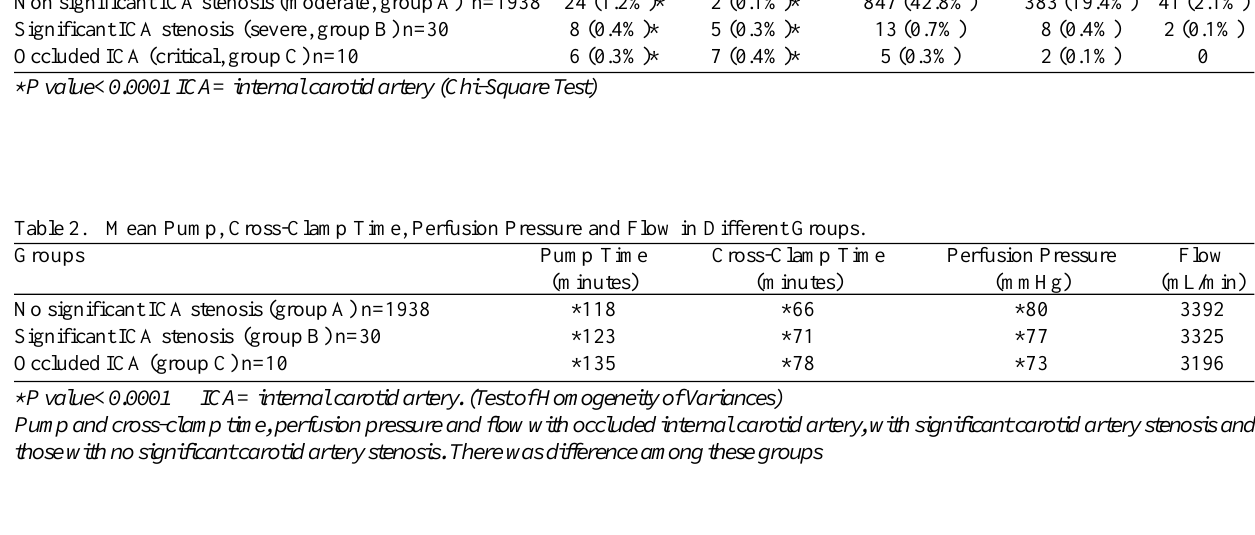
Table 1. Patient Characteristics and Clinical Results in Different Groups. Groups